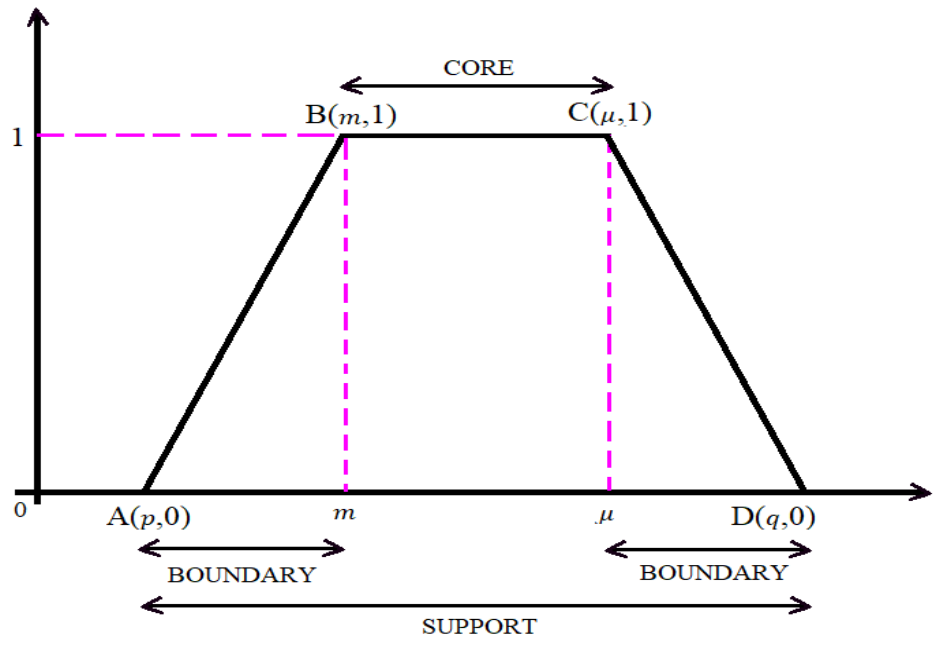
Figure 2. A trapezium to represent TpFN [46].